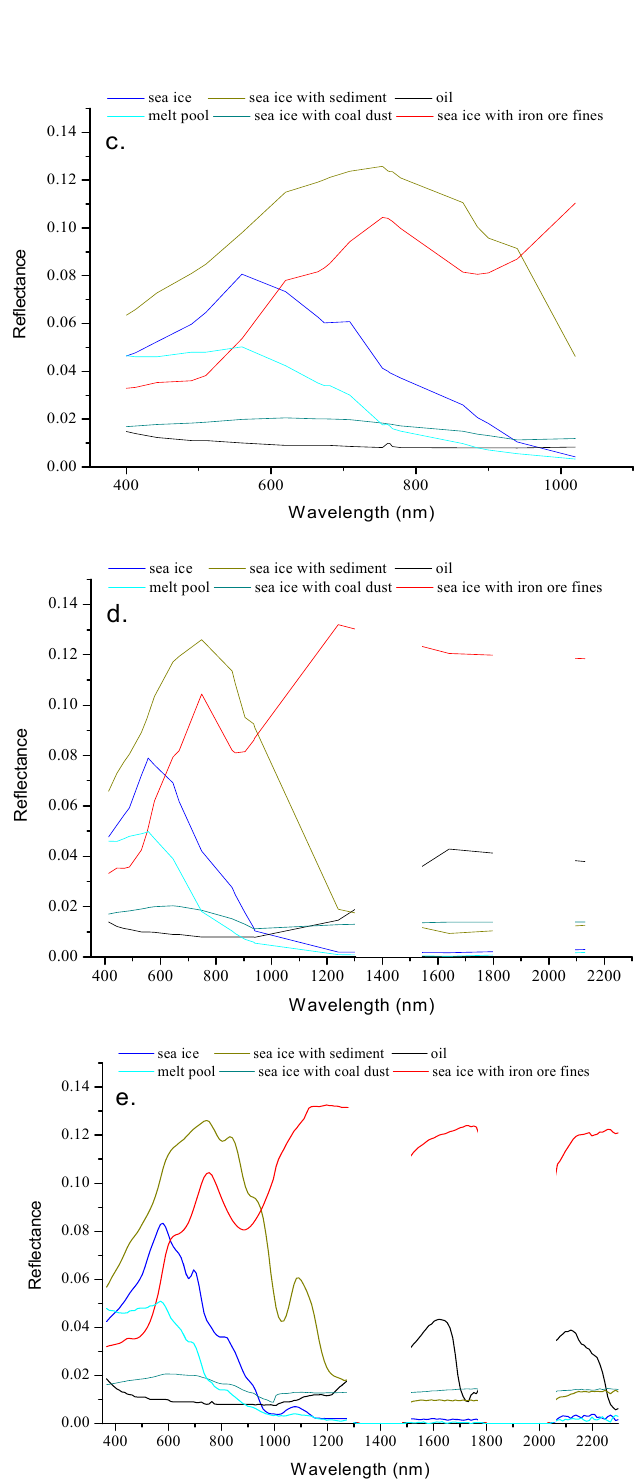
Figure 10. Reflectances of false targets resampled to the band settings of specific sensors: GF-2 ( a ); Landsat8-OLI ( b ); Sentinel3-OLCI ( c ); MODIS ( d ); and, AVIRIS ( e ).